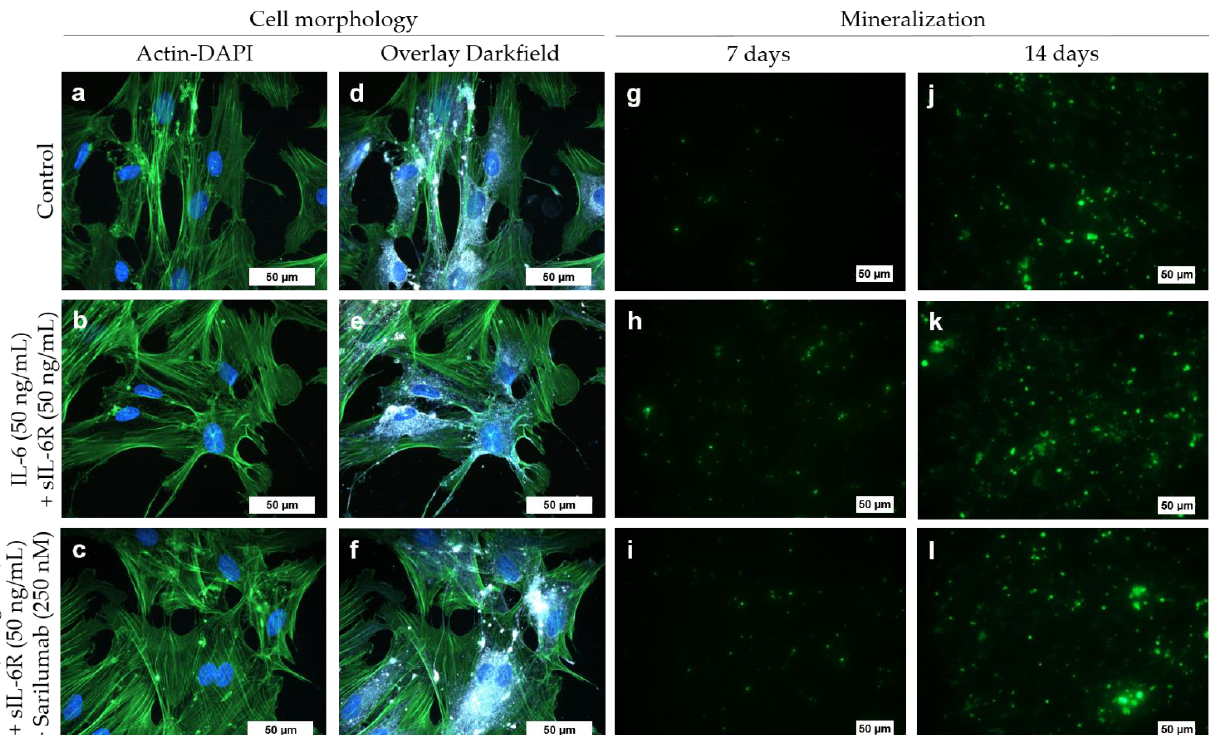
Figure 6. Cell morphology ( a – f ) and mineralization capacity ( g – l ) of human osteoblasts following exposure to IL-6, sIL-6R ± sarilumab over 72 h in calcium-supplemented medium (passage 3, male donor, 68 year). ( a – c ) Fluorescence stain of the actin cytoskeleton (green fluorescence) and cell nuclei (blue fluorescence; bar: 50 µm). ( d – f ) Overlay of the stained actin cytoskeleton, nuclei, and enhanced darkfield microscopy to visualize intra- and extracellular structures (bar: 50 µm). ( g – l ) after 7 and 14 days (bar: 50 µ